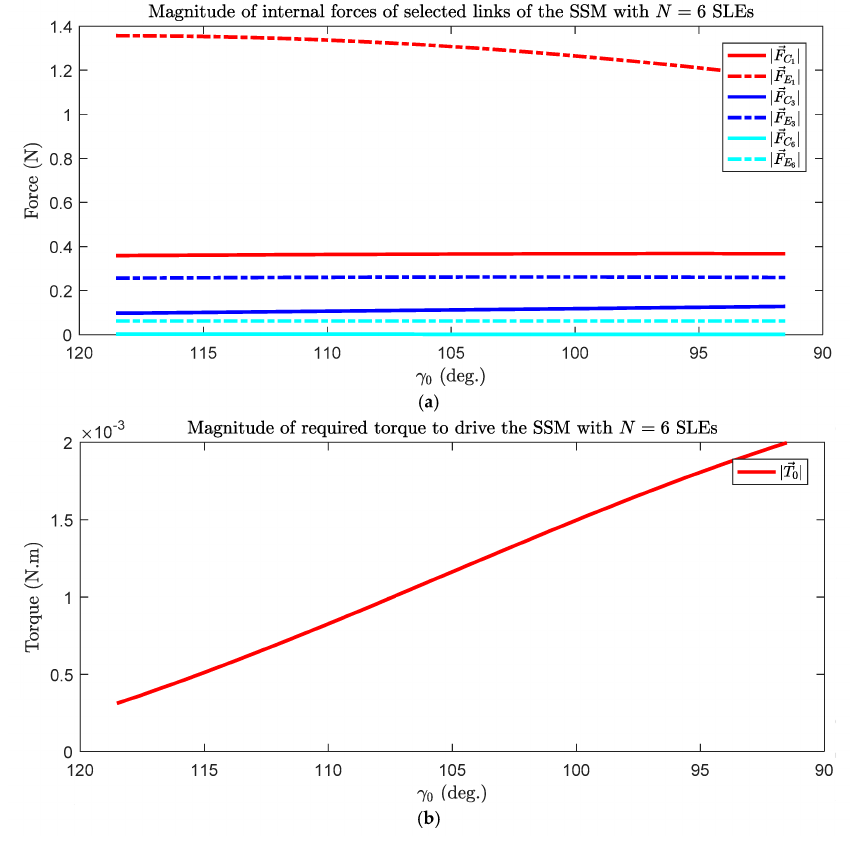
Figure 11. ( a ) Magnitude of internal forces of selected links of the SSM and ( b ) magnitude of the required torque to drive the SSM with N = 6 SLEs for NACA